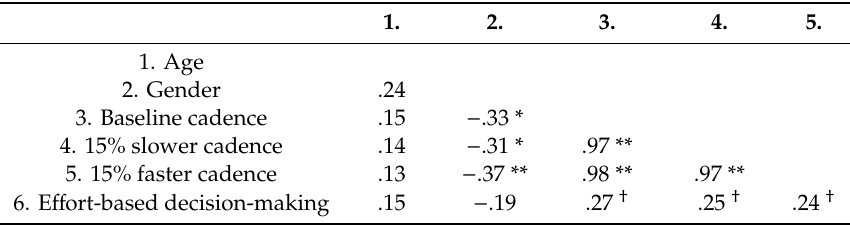
Bivariate correlations between demographic information, cadence, and e ff ort-based decision-making ( N =